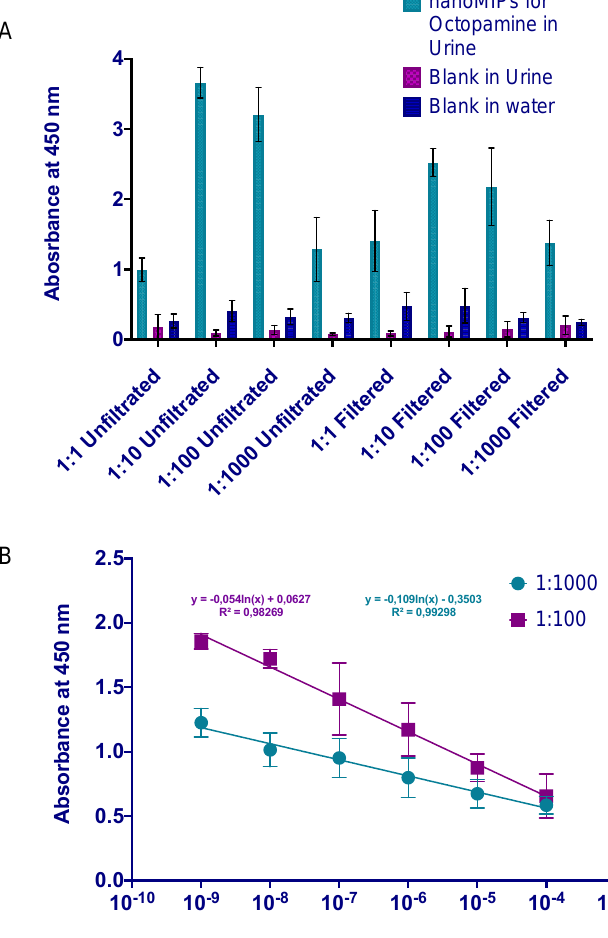
Figure 5. ( A ). Optimisation of the MINA assay in human urine. Urine was separated into two groups; filtrated and unfiltrated samples. Then the samples were separated into four different dilutions. ( B ) MINA calibration curve for the best two dilutions of filtrated human urine (1:100 and 1:1000). Error bars represent the standard deviation for experiments performed in triplicate.